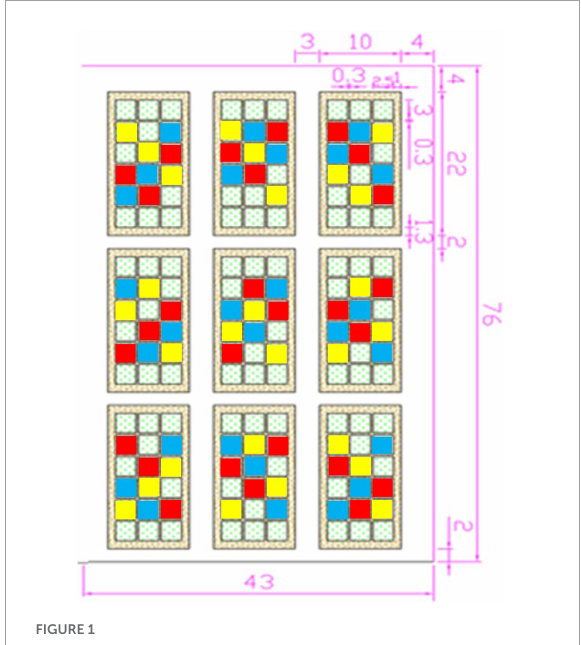
FIGURE1 Experimental plot (dotted square: other forages planted were not studied in this paper; blue square: monocultures of Medicago sativa ; red square: monocultures of Elymus nutans ; and yellow square: E.n and M.s